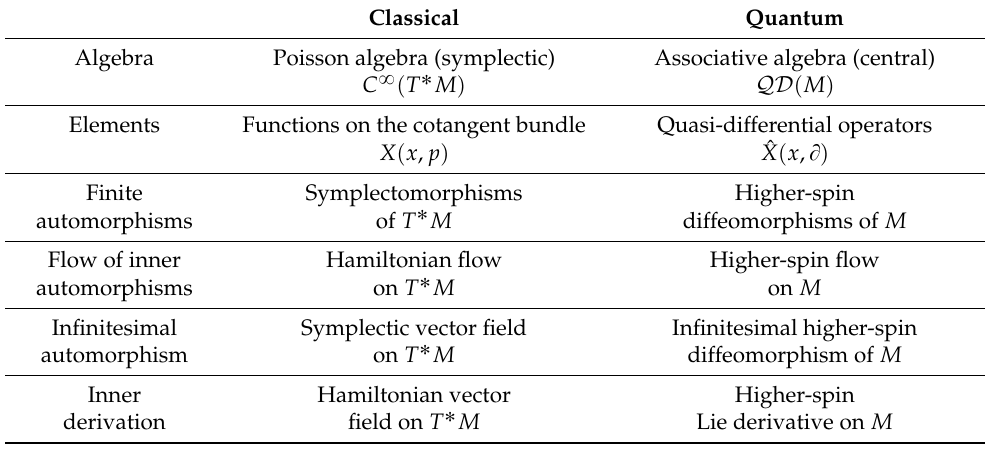
Table 4. Automorphisms of classical versus quantum algebras of functions on the cotangent